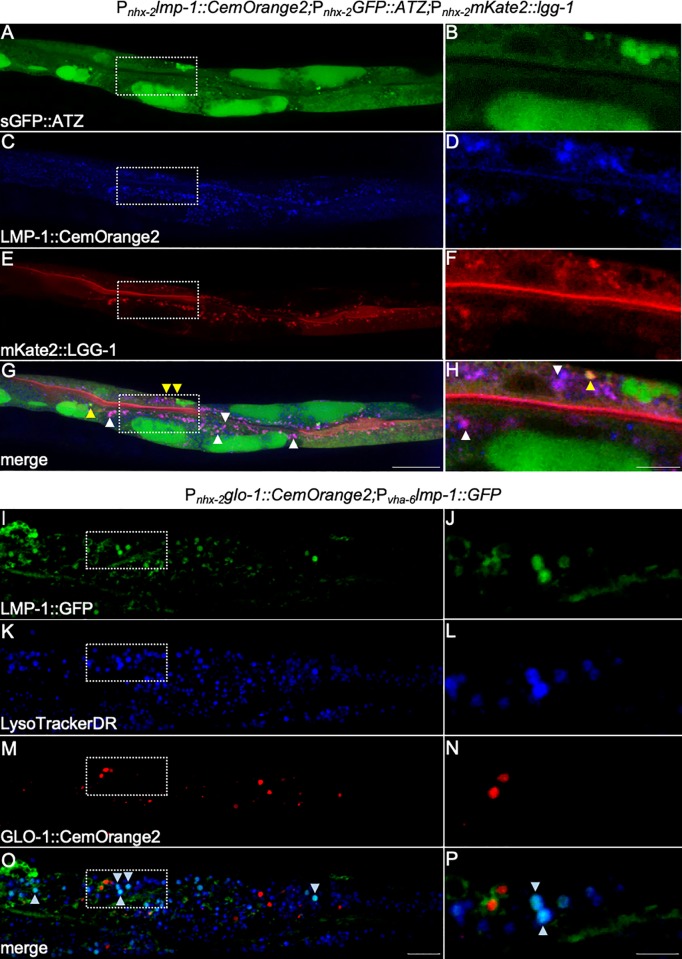
CemOrange2 and three-color imaging.Pnhx-2lmp-1::CemOrange2;Pnhx-2GFP::ATZ;Pnhx-2mKate2::lgg-1 transgenic C. elegans expressing sGFP::ATZ (A and B; green; Ex488 nm/Em500-540 nm), LMP-1::CemOrange2 (C and D; pseudocolored blue; Ex545 nm/ Em560-590 nm) and mKate2::LGG-1 (E and F; red; Ex594 nm/Em605-645 nm) were examined by confocal microscopy over >20 z-planes using a 40x PlanApo oil immersion objective (N.A. 1.3). Maximum intensity projections are shown (A, C, E, G). Scale bars = 25 μm. Magnified single XY regions (dashed box) are included to highlight colocalization events (B, D, F, H). Scale bars = 5 μm. mKate2::LGG-1 and LMP-1::CemOrange2 had multiple colocalization events (G and H; magenta merge, white arrowheads). Alpha-1 antitrypsin Z mutation (ATZ), a polymerizing protein which accumulates in the ER and is degraded, in part, by autophagy, show colocalization with mKate2::LGG-1 (G and H; orange merge, yellow arrowheads). Pnhx-2glo-1::CemOrange2;Pvha-6lmp-1::GFP transgenic C. elegans expressing LMP-1::GFP (I and J, green; Ex488 nm/Em500-540 nm) and GLO-1::CemOrange2 (M and N, red; Ex555 nm/Em560-590 nm) were stained with the acidic organelle fluorescent dye, LTDR (K and L, blue; Ex647 nm/Em660-700 nm). Animals were imaged by confocal microscopy over >20 z-planes and maximum intensity projections are shown (I, K, M, O). Scale bars = 25 μm. Magnified single XY regions (dashed box) are included to highlight colocalization events (J, L, N, P). Scale bars = 5 μm. Colocalization events are seen between LMP-1::GFP and LTDR (O and P, cyan merge, arrowheads) but not with GLO-1::CemOrange2.